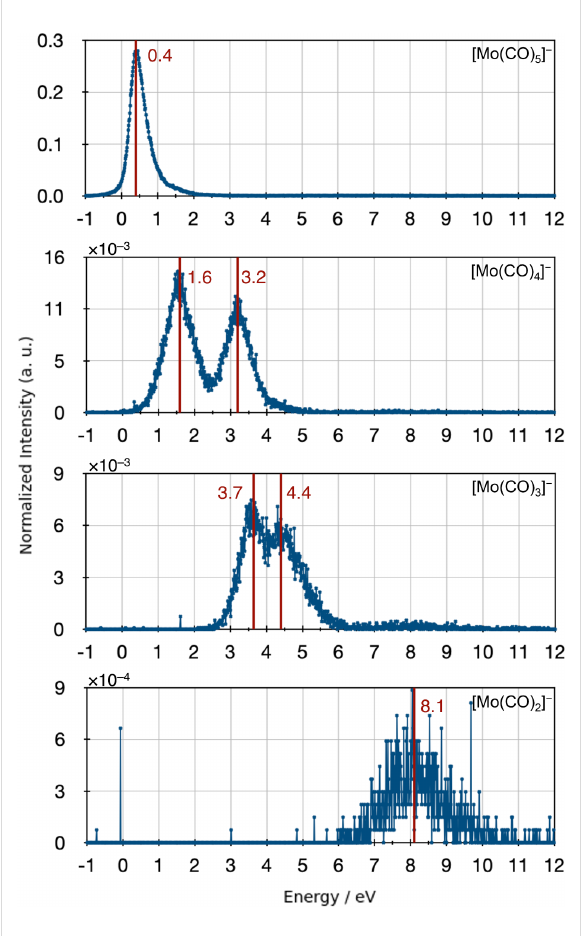
Figure 1: Negative ion yield curves from DEA to Mo(CO) 6 in the energy range from about 0–12 eV. From top; formation of [Mo(CO) 5 ] − ( m / z 236), [Mo(CO) 4 ] − ( m / z 208), [Mo(CO) 3 ] − ( m / z 180) and [Mo(CO) 2 ] − ( m / z